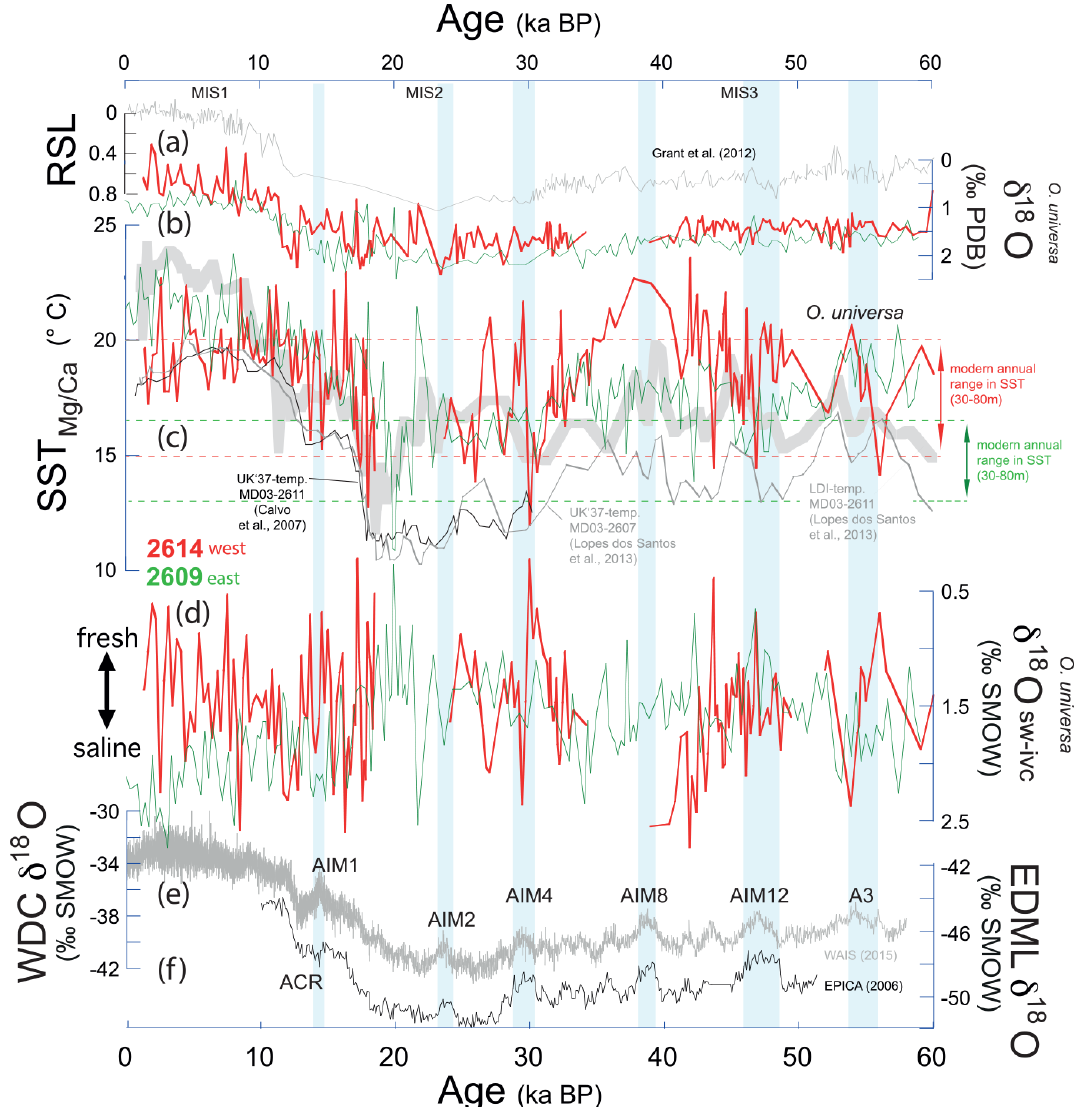
Figure 4. Hydrographic development at sea surface over the last 60kyr. Colored curves represent this study, while grey and black curves represent reference records. (a) Relative sea level curve of Grant et al. (2012) (in ‰). (b) Sea surface δ 18 O O. universa records at the western (red; core 2614) and the eastern (green; core 2609) core locations. (c) SST Mg / Ca records derived from O. universa (red: core 2614; green: core 2609). The long-chain diol-based SST LDI (thick grey) and alkenone-based SST UK (cid:48) 37 records (thin grey and black) of nearby cores MD03- 2607 and MD03-2611 (Calvo et al., 2007; Lopes dos Santos et al., 2013) are for comparison. (d) Relative sea surface salinity approximations ( δ 18 O sw-ivc ) at the western (red) and eastern (green) core locations. (e) West Antarctic Ice Sheet Divide Core (grey; WAIS Divide Project Members, 2015) and (f) the EDML (black; EPICA Community Members, 2006) δ 18 O records as reference for the Southern Hemisphere climate signal. Blue shading shows the Antarctic Isotope Maxima (AIM). Dashed red and green lines show the modern annual SST range at 50–100m water depth at the eastern and western core locations 2609 and 2614, respectively (Locarnini et al., 2019). MIS stands for Marine Isotope Stages 1–3 (Martinson et al.,